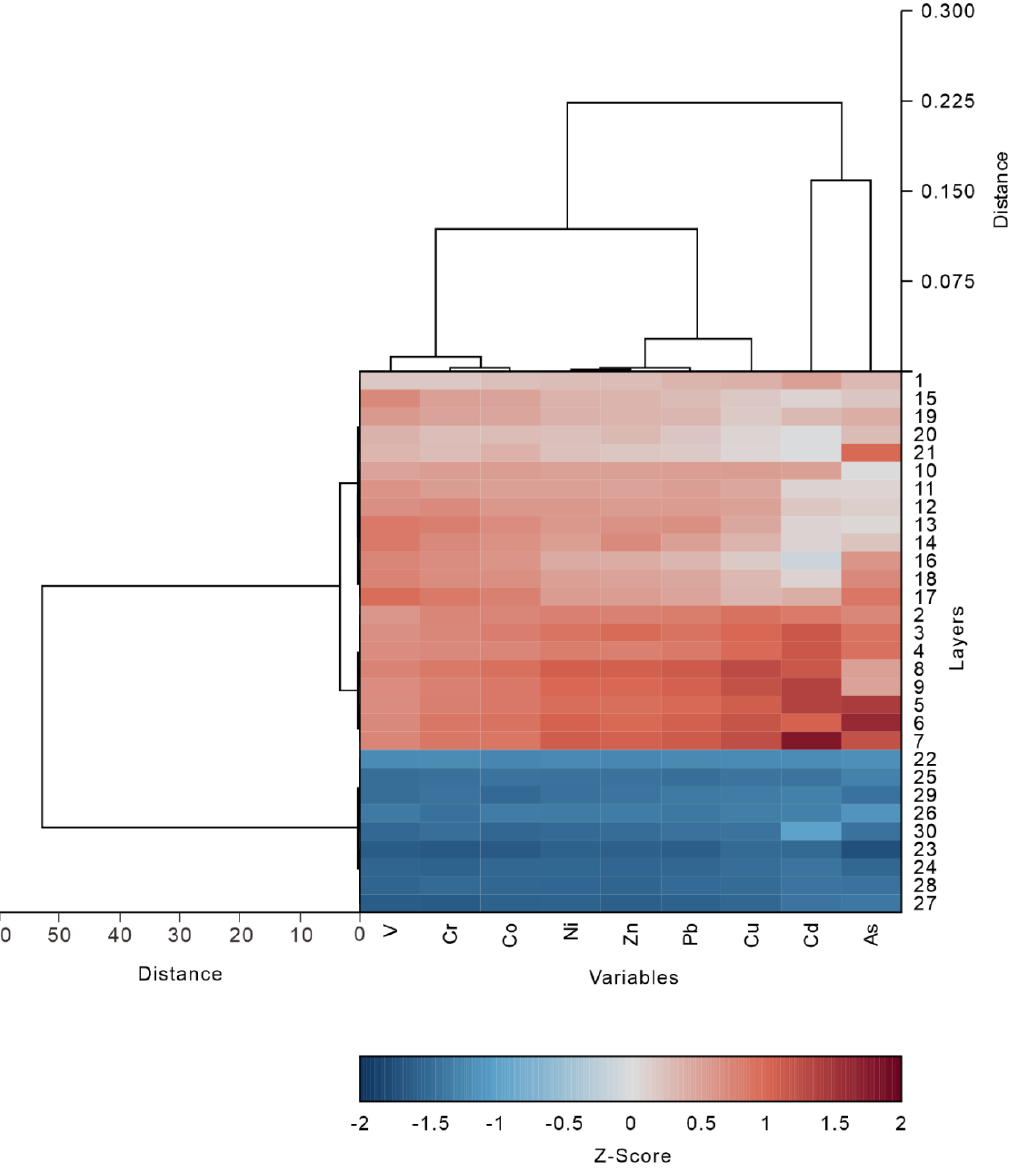
Figure 3. Cluster dendrogram for samples and PTE concentrations.